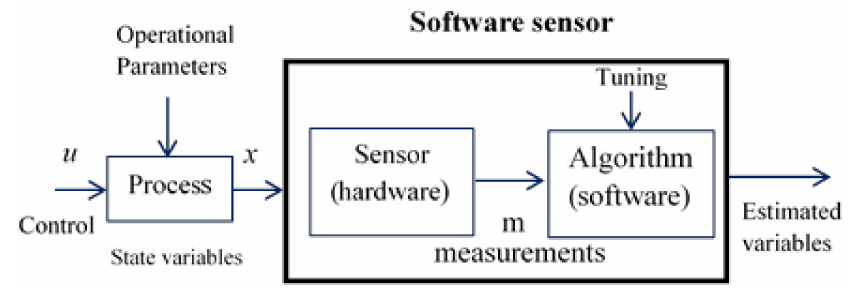
Figure 1. Idea of a software sensor.